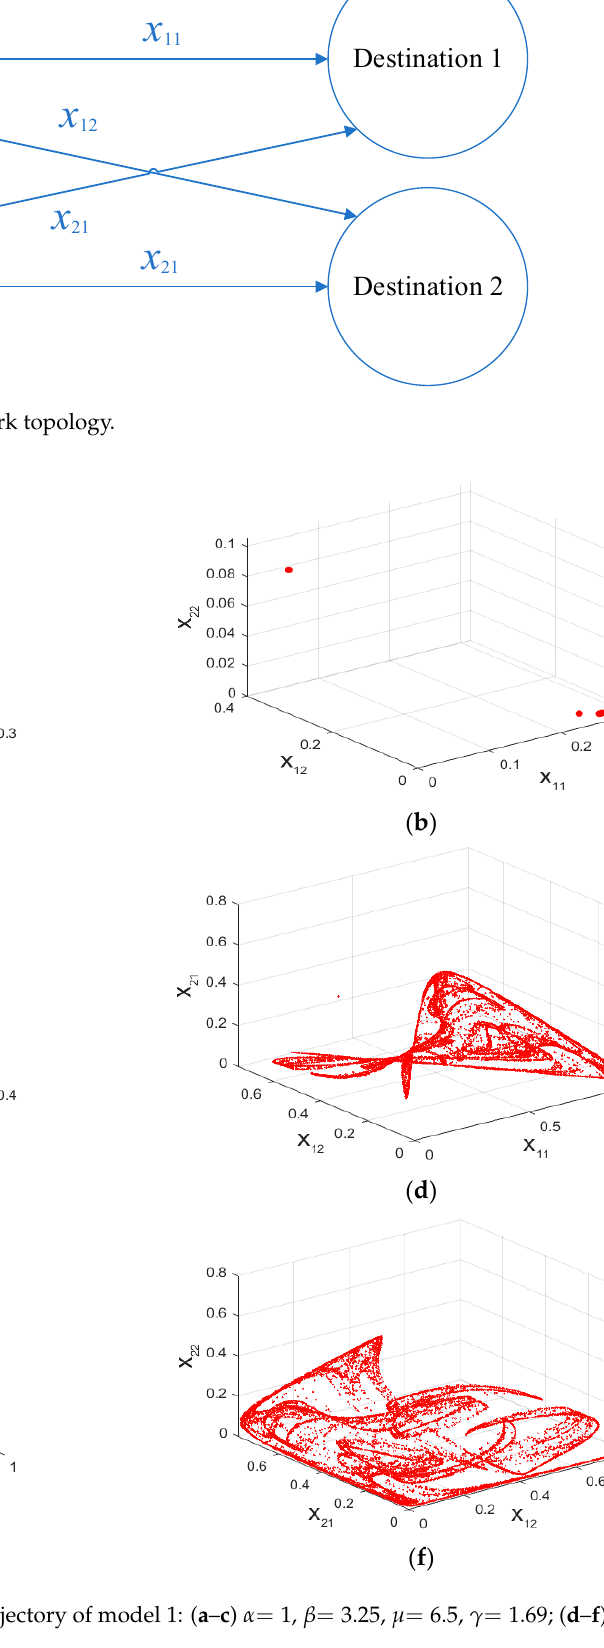
( f ) Figure 2. The phase trajectory of model 1 : ( a – c )